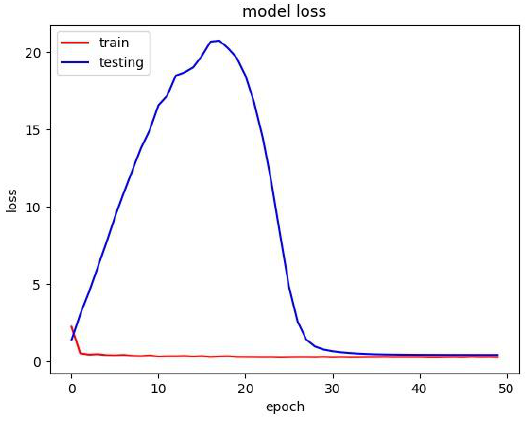
Figure 11. Cough Model Loss